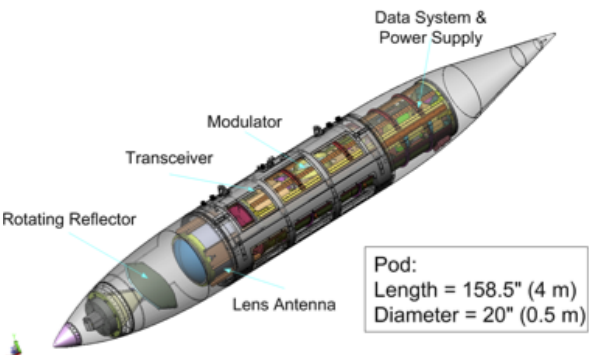
Figure 2. Side view of the 20 (cid:48)(cid:48) HIAPER wing pod showing the layout of the radar electronics. The front of the pod is on the left- hand side of the figure. The reflector plate is positioned such that the beam clears the leading edge of the wing when pointing toward